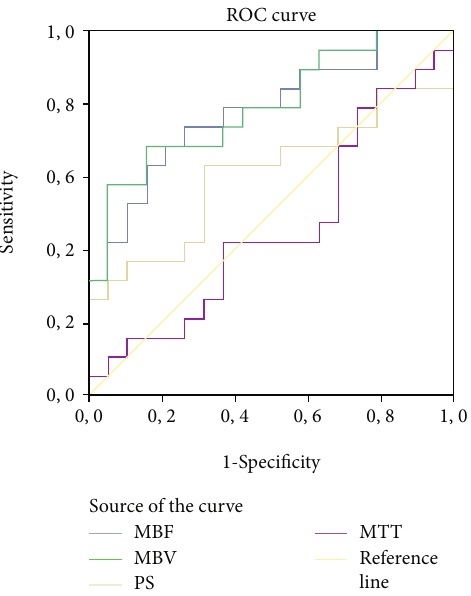
Figure 5: ROC analysis of the perfusion values in parathyroid adenomas compared to thyroid